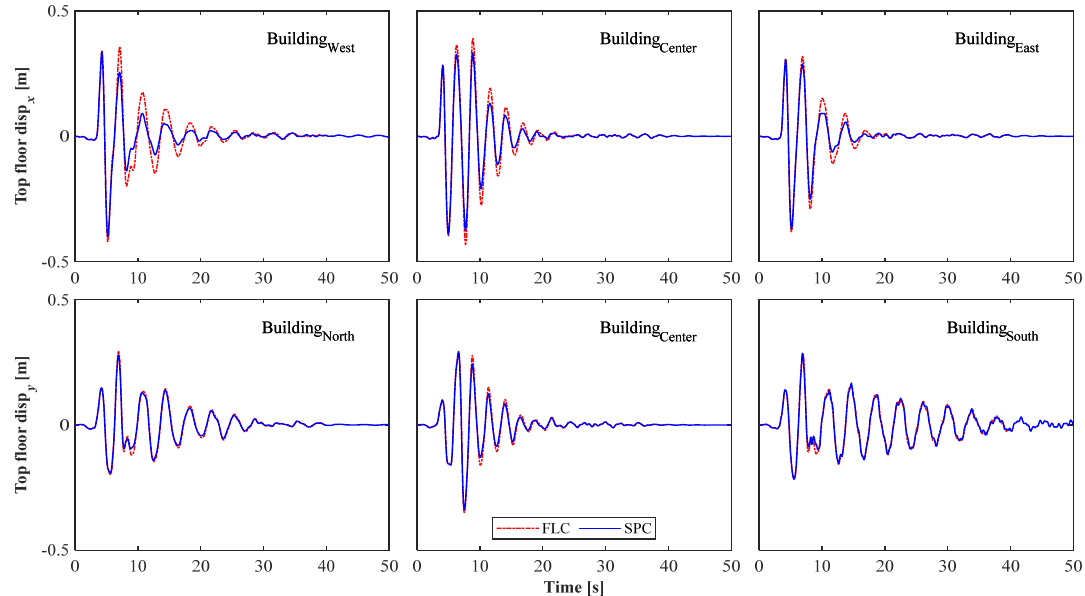
Figure 18. Comparison of the responses using fuzzy logic control (FLC) and SPC algorithms under the Northridge earthquake.